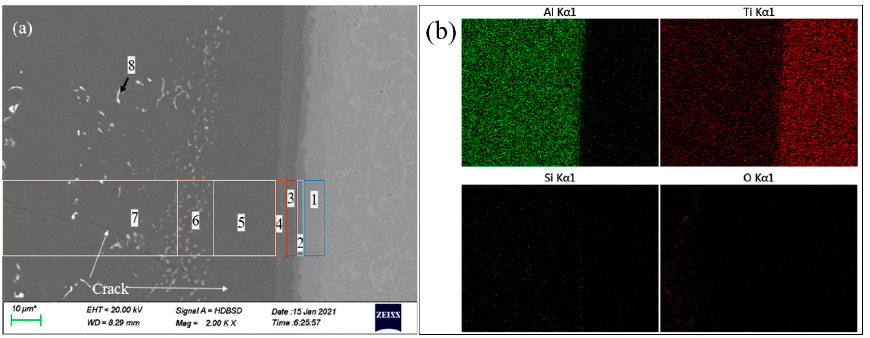
Figure 6. Microstructure ( a ) and EDS mapping date ( b ) of adding a cerium Ti-Al-Si gradient coating after 72 h oxidation. Table 1. EDS data and main compounds of each alloy phase layer.